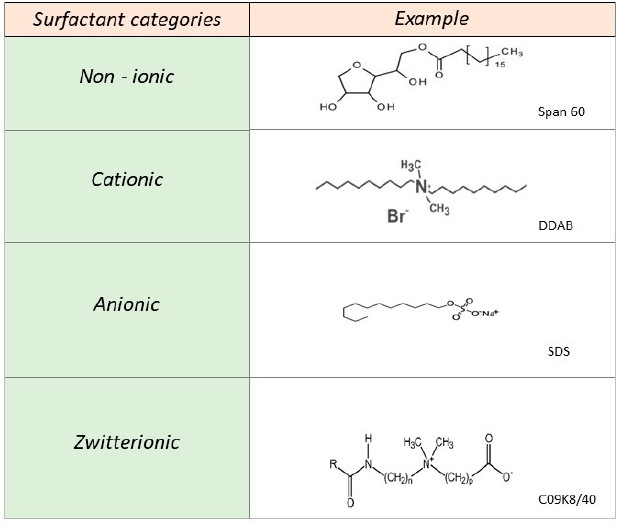
Figure 1. Surfactant classification based on their charge and examples of chemical structures.